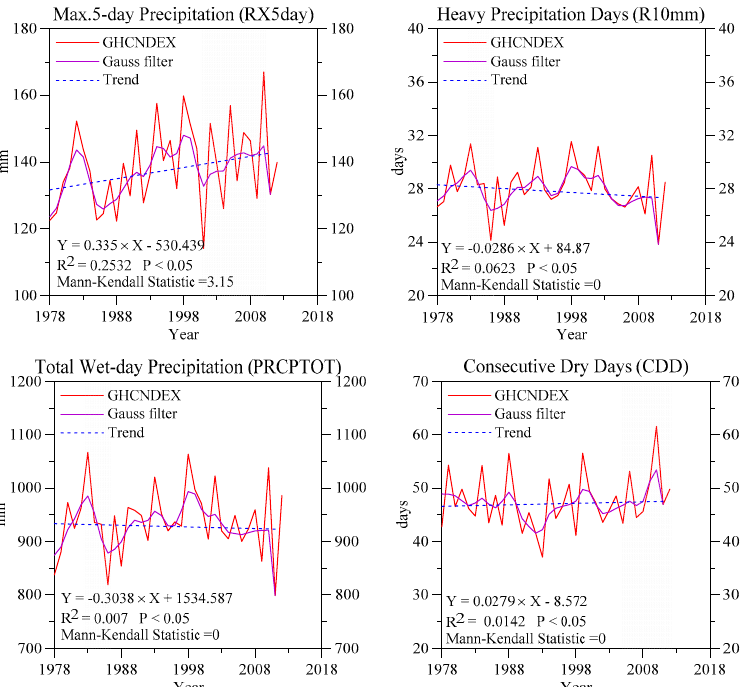
Figure 3. Time series of area-averages Heavy rainfall indices (R × 5 day, R10 mm, PRCPTOT and CDD, and gray area indicates a more significant variability) during the period 1979–2017 based on GHCNDEX data.